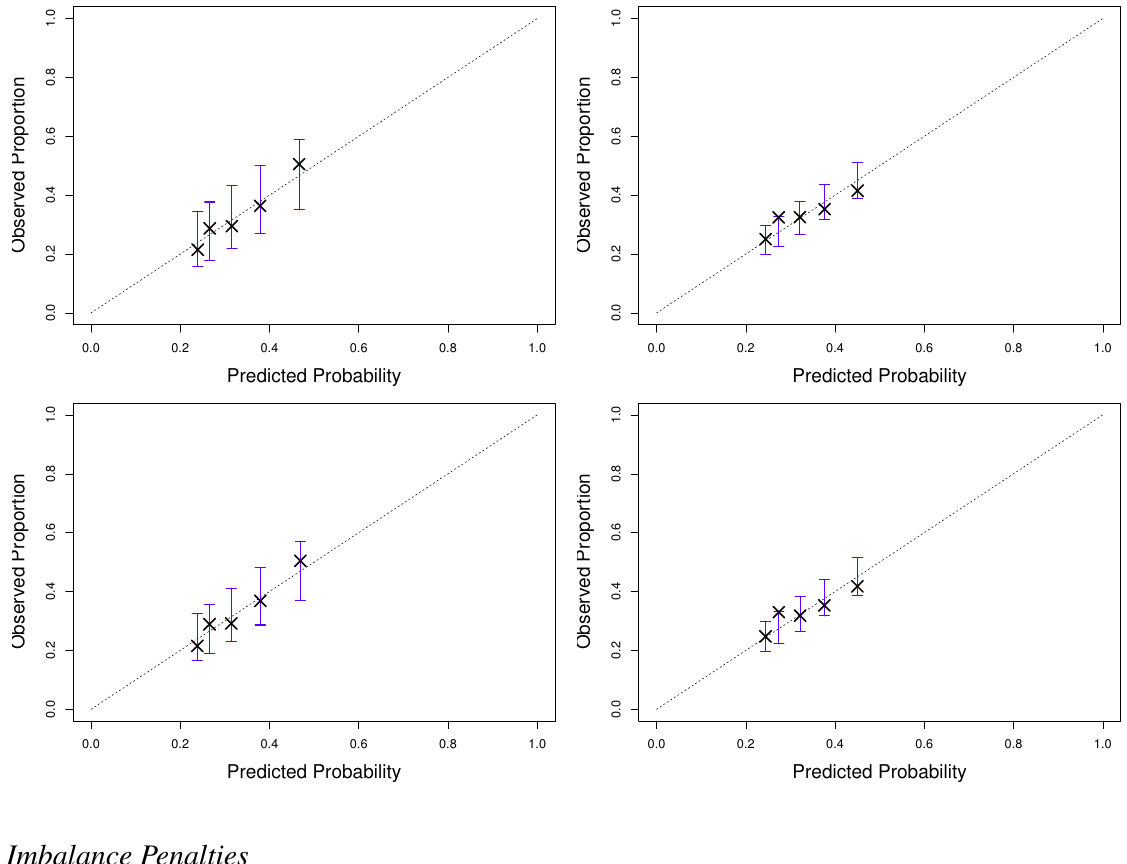
Figure 6. Reliability diagrams for both unconditional ( top row ) and conditional ( bottom row ) models with diurnal seasonalities, over both training and test periods ( left and right columns,